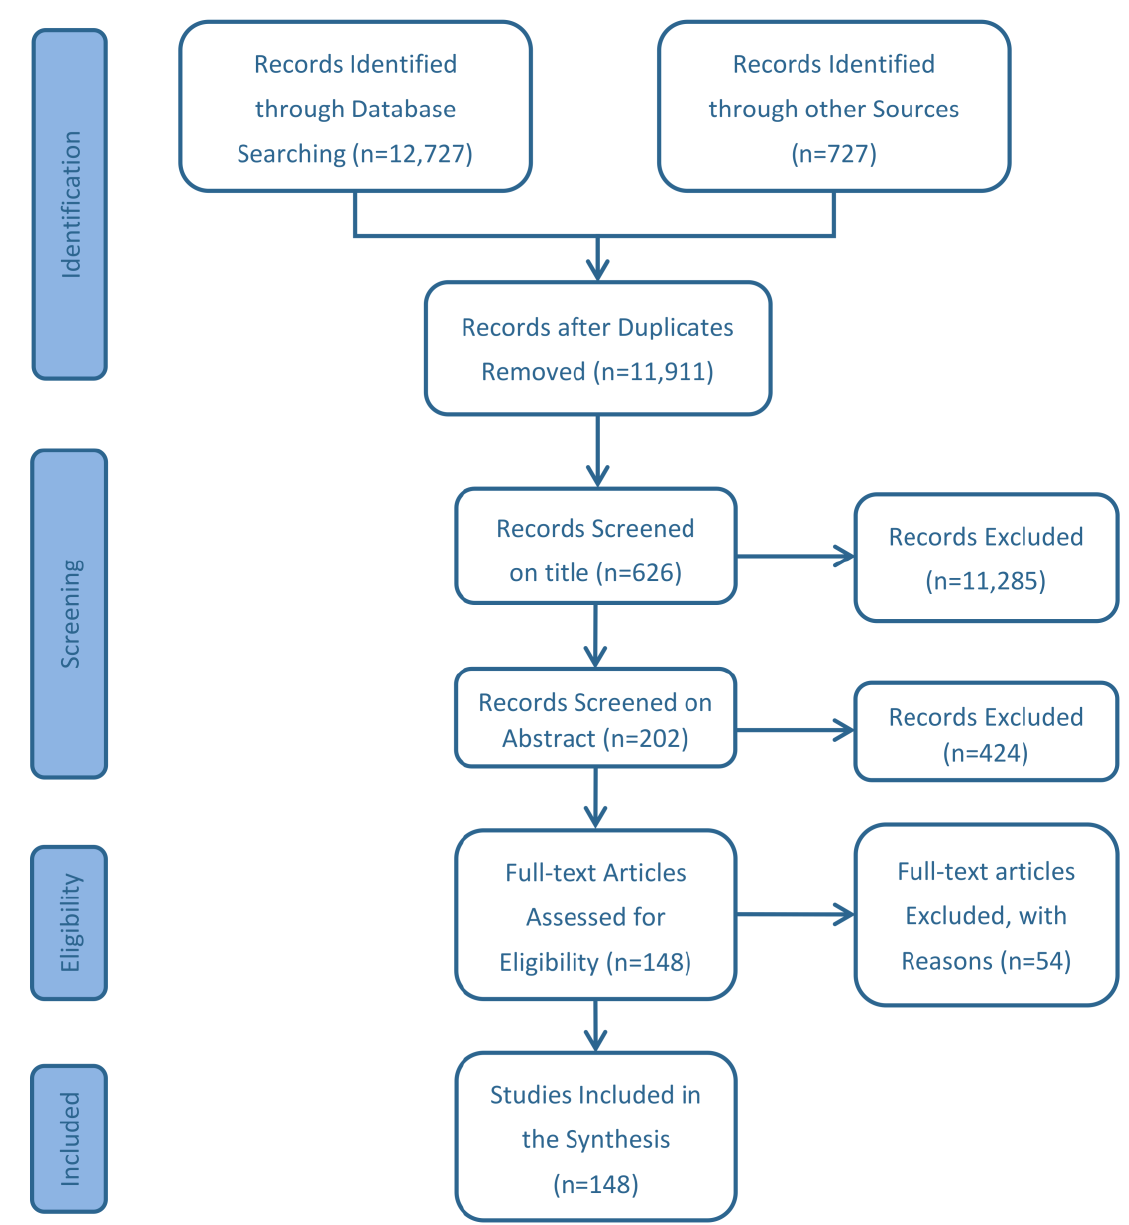
Figure 2. Flow diagram of the systematic review process (after [32]).